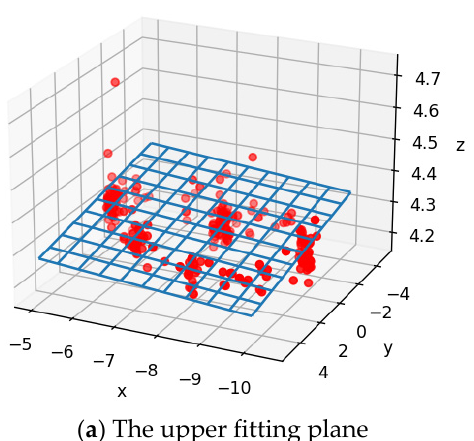
Figure 9. ( a ) is t he upper plane fitting results. ( b ) is the bottom plane fitting result.